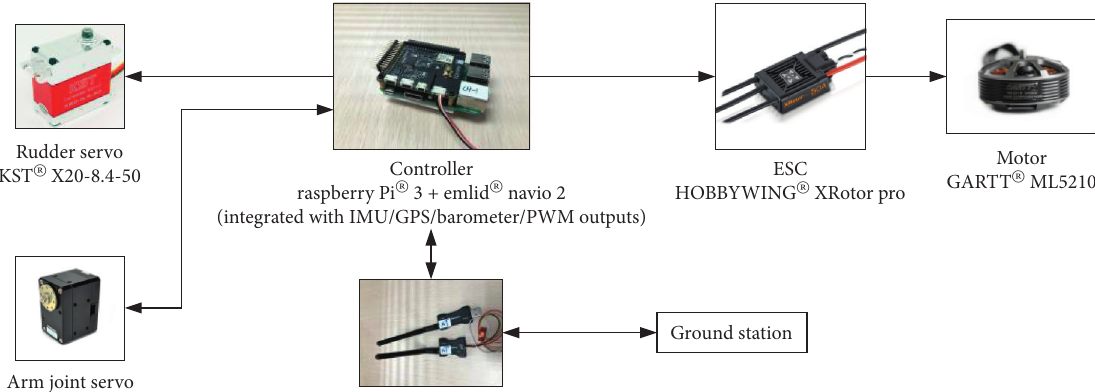
Figure 4: The hardware of control unit.